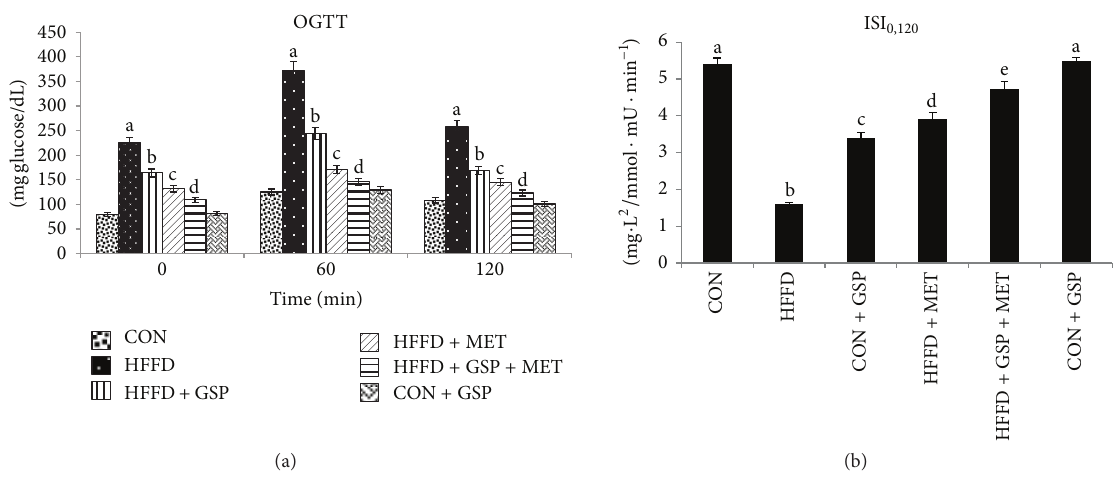
Figure 1: Effect of GSP and MET on oral glucose tolerance test (a) and insulin sensitivity indices (b). Data are expressed as means ± S.D. of 6 rats from each group. Statistical significance between the groups, denoted by different alphabets, was determined by one-way ANOVA of significance set at 𝑃 < 0.05 .